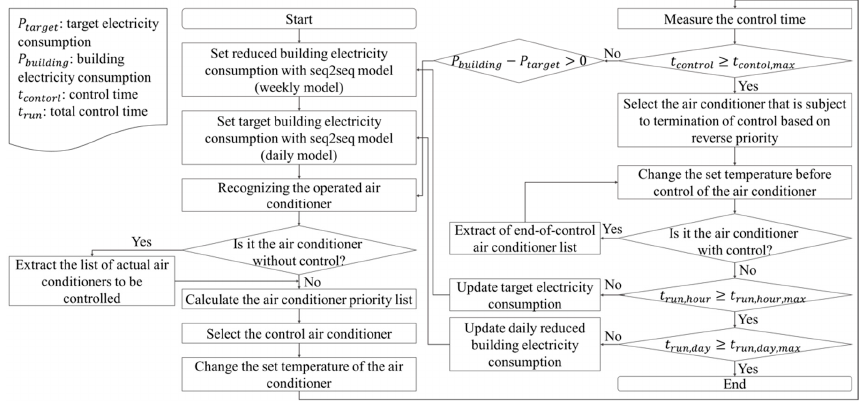
Figure 1. A flow chart of the building control algorithm.